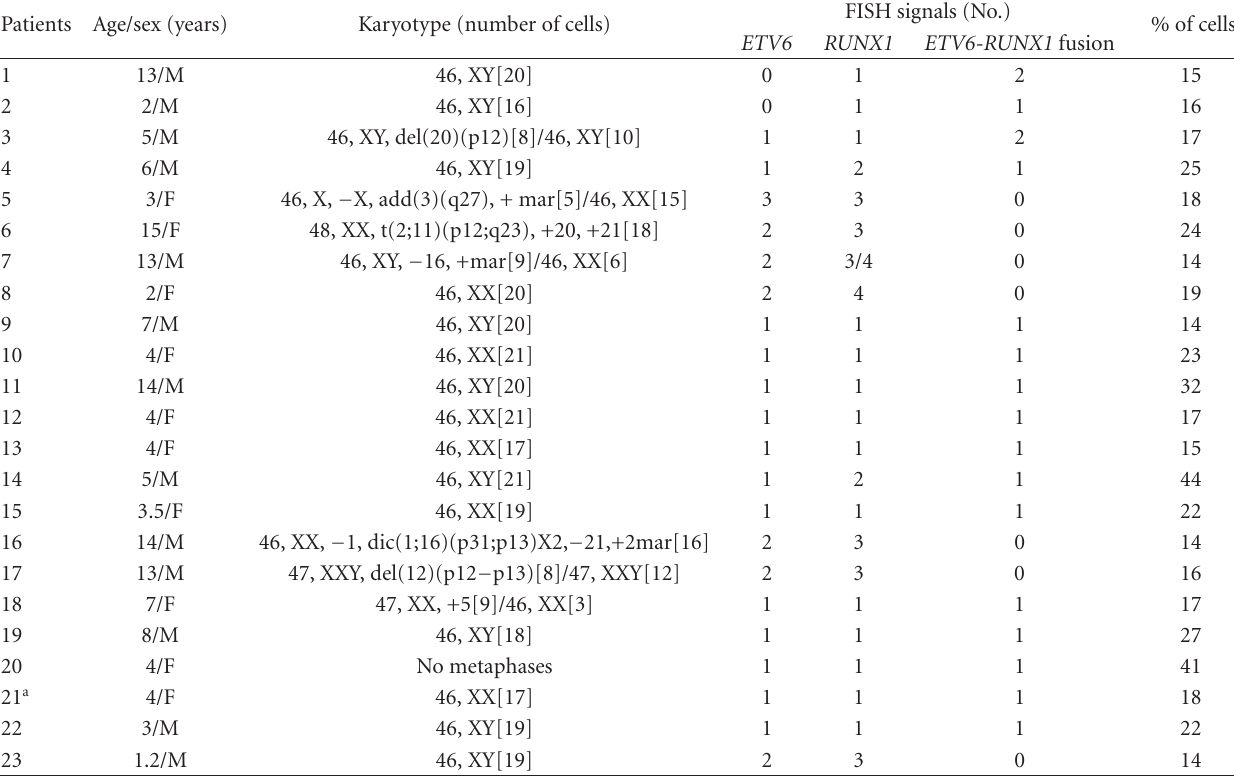
Table 1: Summary of patients with abnormal FISH findings. Patients Age/sex